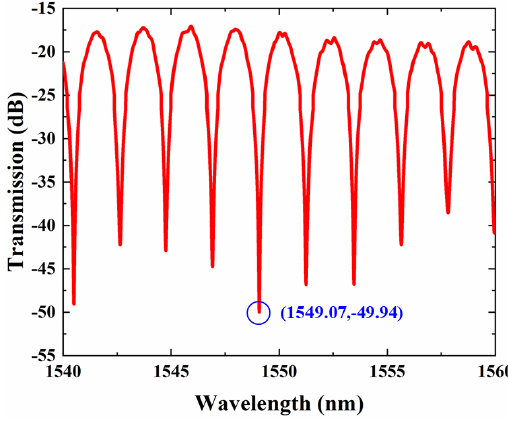
Figure 6. The spectrum of our designed AMZI.